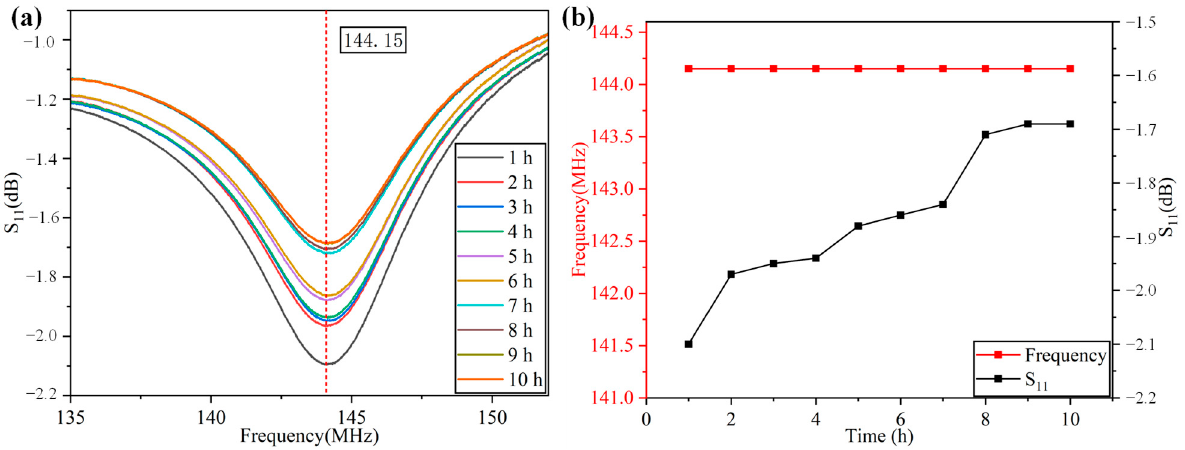
Figure 13. ( a ) S 11 -frequency characteristic curve in a high-temperature holding experiment at 300 °C for 10 hours; ( b ) frequency and S 11 change with the length of time maintained at 300 °C